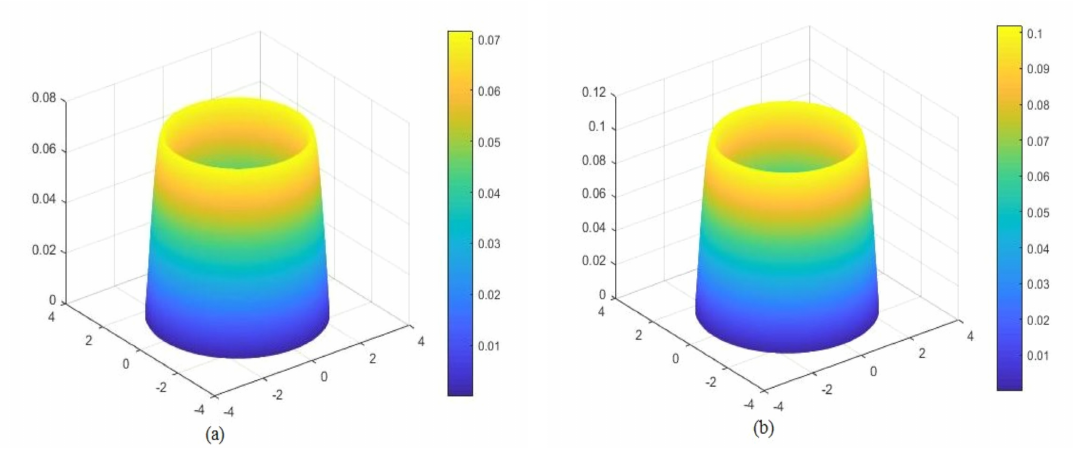
Figure 9. ( a ) The NBE solution u k at t = 0.4. ( b ) The analytical solution u k